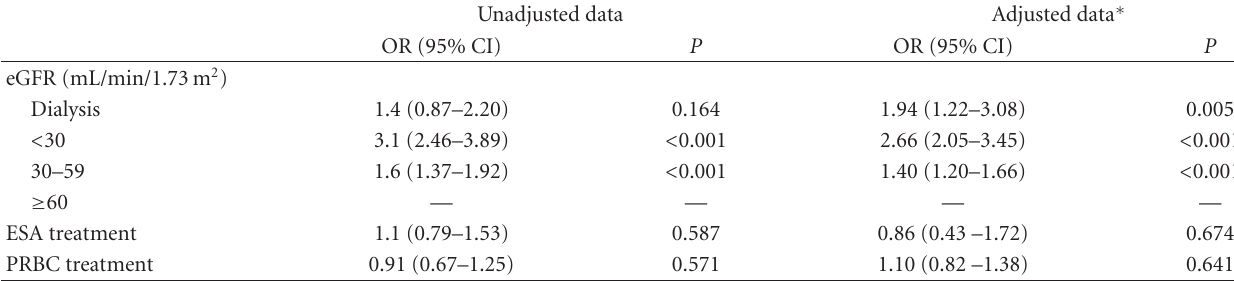
Table 5: Odds ratios for mortality based on eGFR, ESA, and PRBC